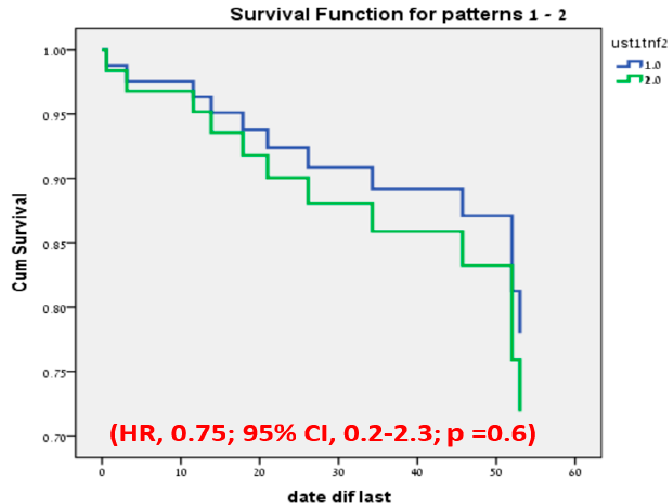
Figure 4. Cox regression test of treatment discontinuation-free analysis; UST1, ustekinumab; TNF2, anti-tumor necrosis factor; HR, hazard ratio; CI, con fi dence interval; p , p